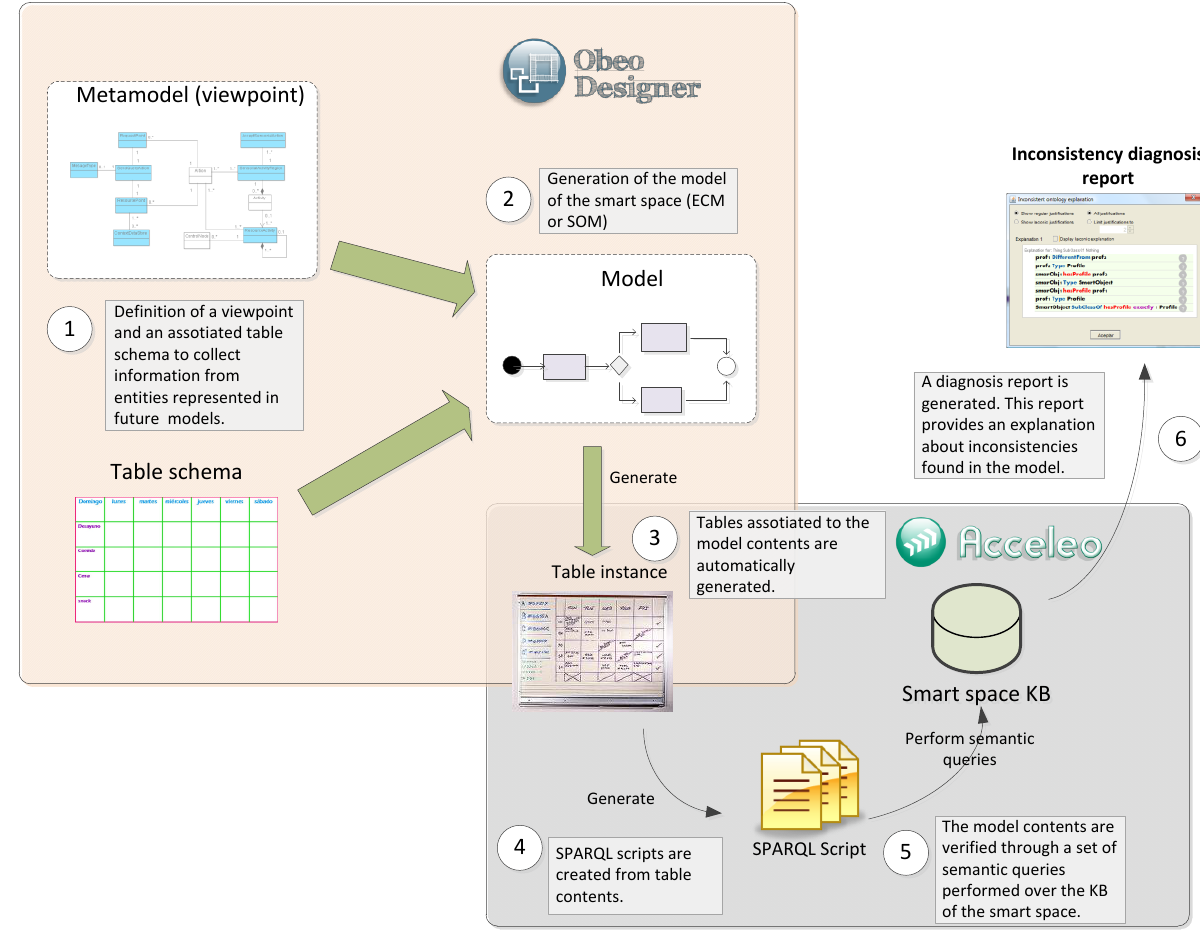
Figure 19. Verification process for validating the semantic information contained in a diagram.